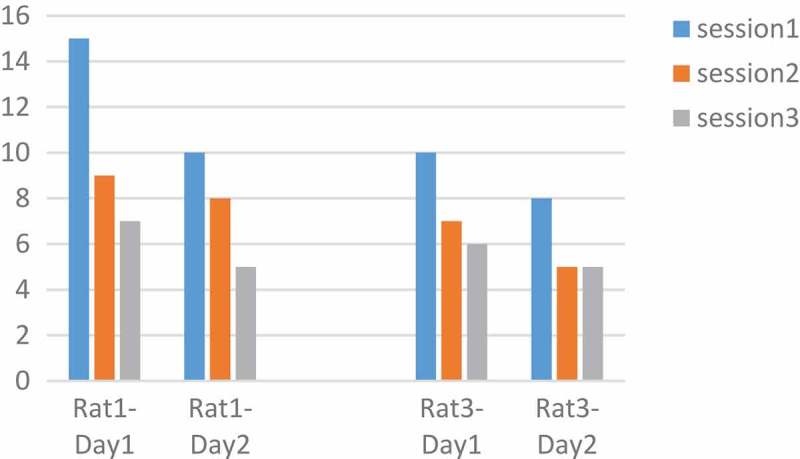
Performance of rats at 130 µA. Rats No 4,5 with 20 biphasic pulse, amplitude:130 µA, pulse width:1000 µs, frequency:100 Hz.